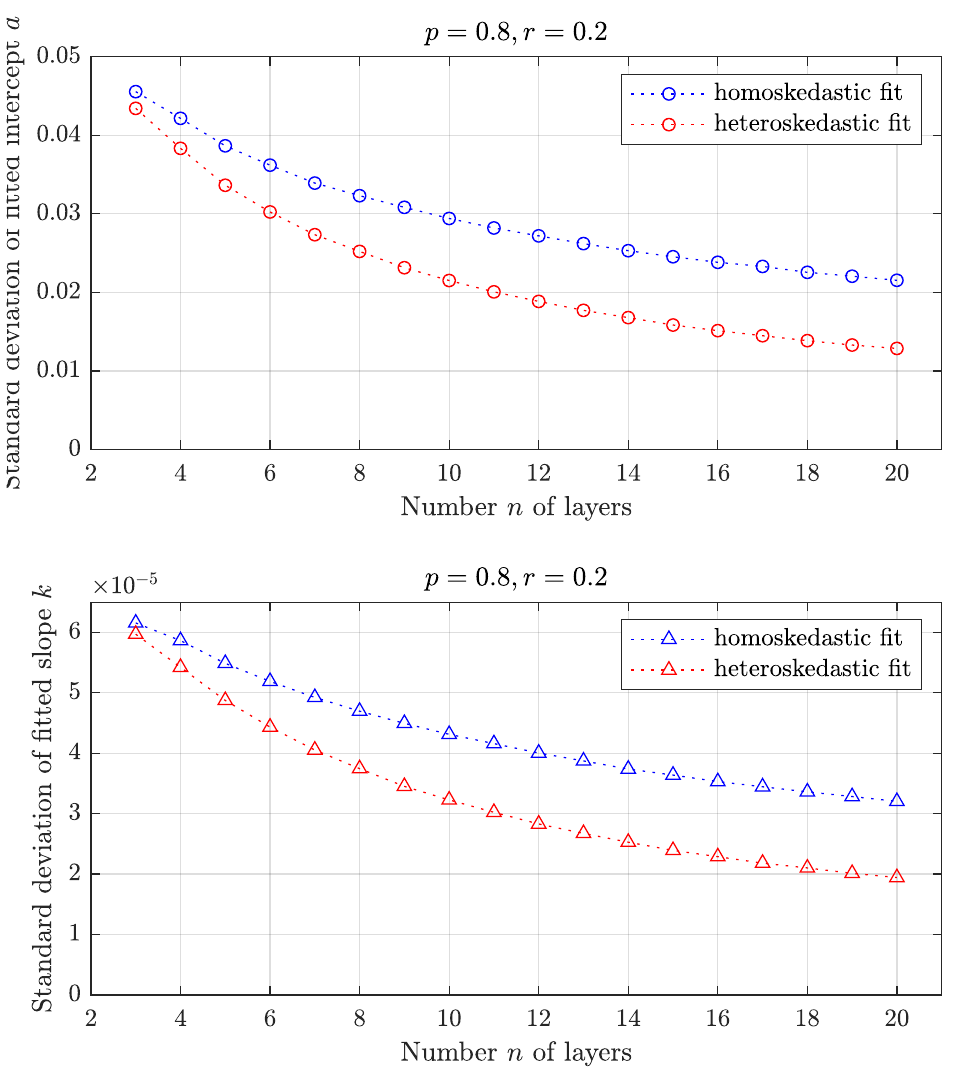
Figure 1. Top : estimated rms and exact standard deviation of the fitted intercept d ; bottom : estimated rms and exact standard deviation of the fitted slope k , for p = 0.8, r = 0.2 in the range 3 ≤ n ≤